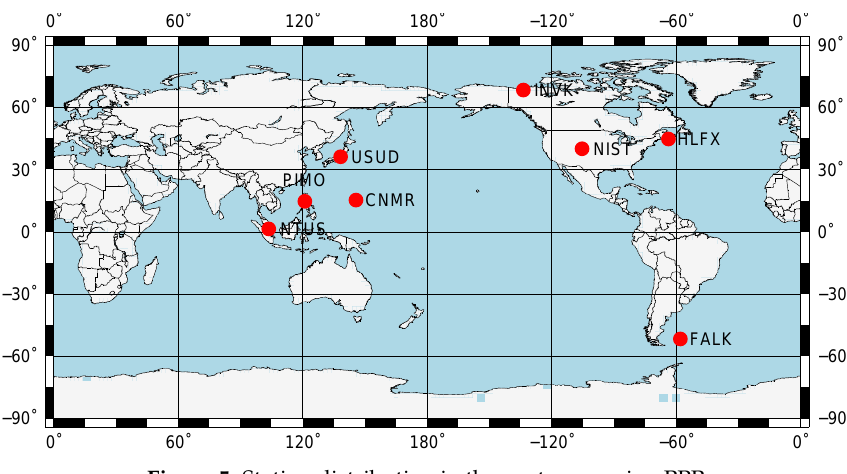
Figure 5. Station distribution in the post-processing PPP.